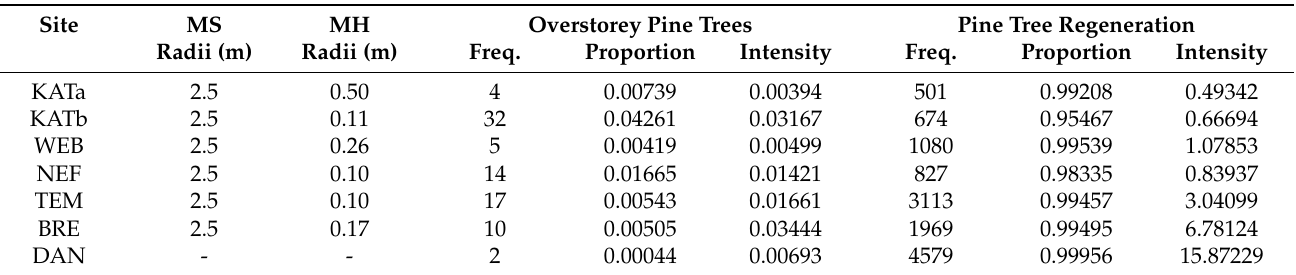
Table 8. Calculations with optimised radii, interaction radii of non-stationary multitype Strauss (MS) and multitype hard-core (MH) processes, and calculated frequencies, proportions, and intensities of overstorey pine trees and seedings ( ≤ 10 years).